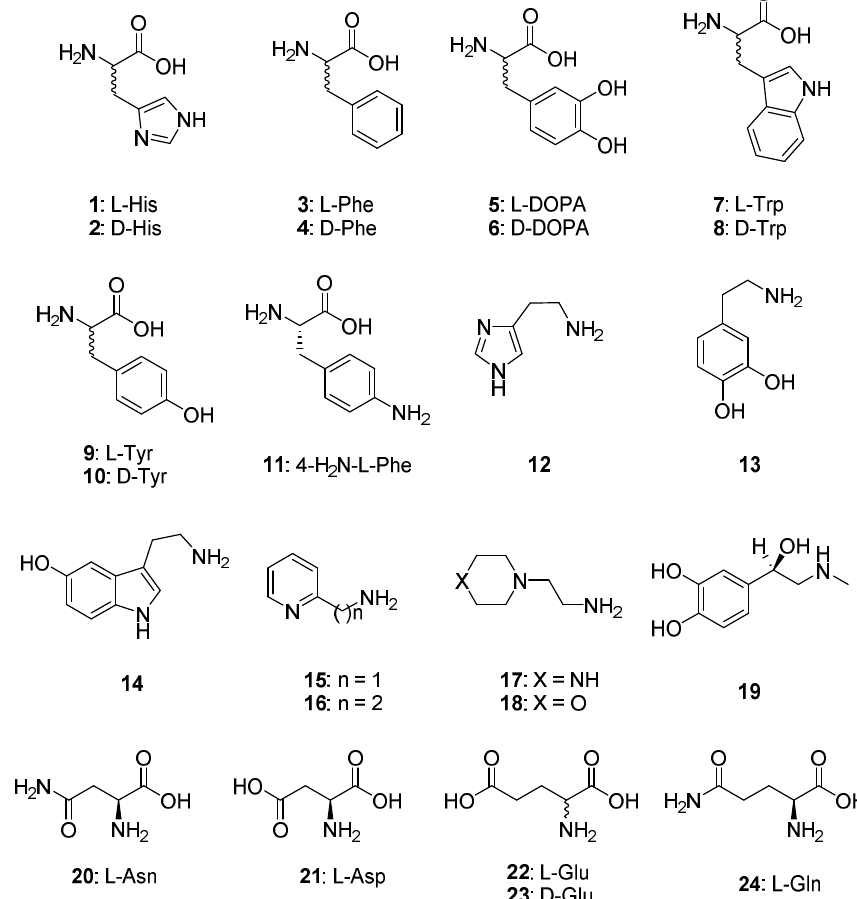
Figure 1. CAAs of type 1-24 used in the present study.